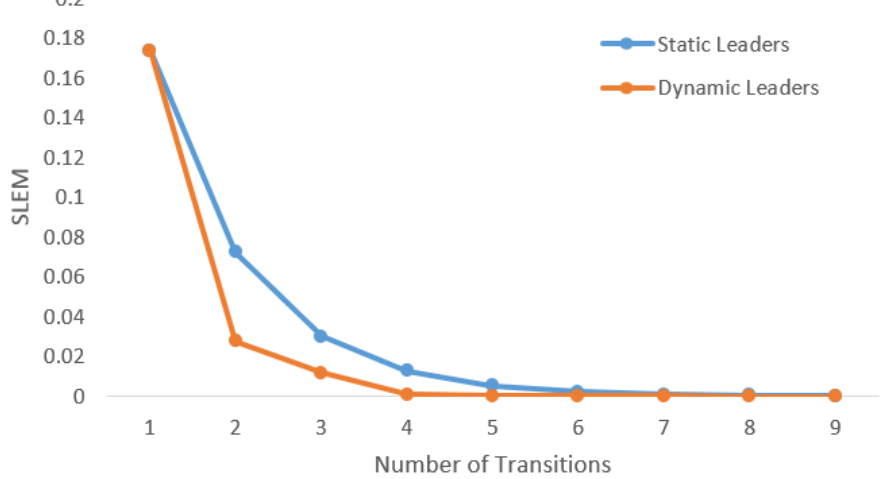
Figure 5. Improvement in convergence rate due to introducing mobility among the